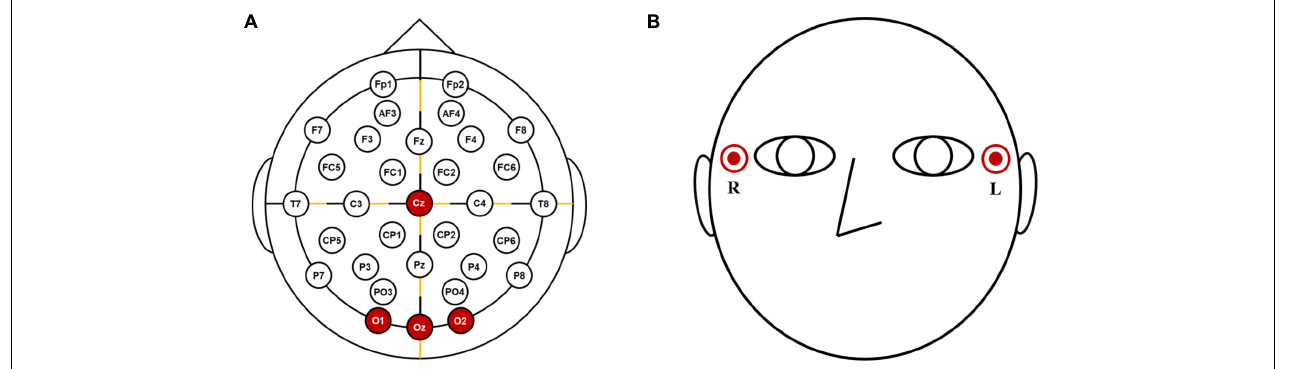
FIGURE 1 | The configurations of the electrodes: (A) locations of EEG electrodes and (B) EOG electrodes.